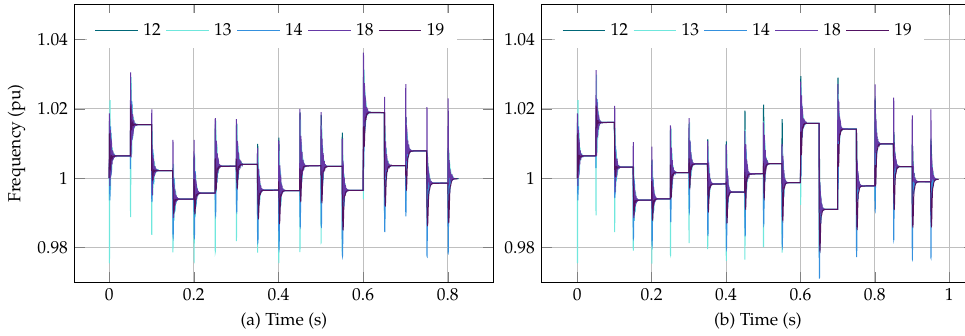
Figure 6. Frequency dynamics at each converter for load case 1. ( a ) Constant load model. ( b ) Frequency-dependent load model.